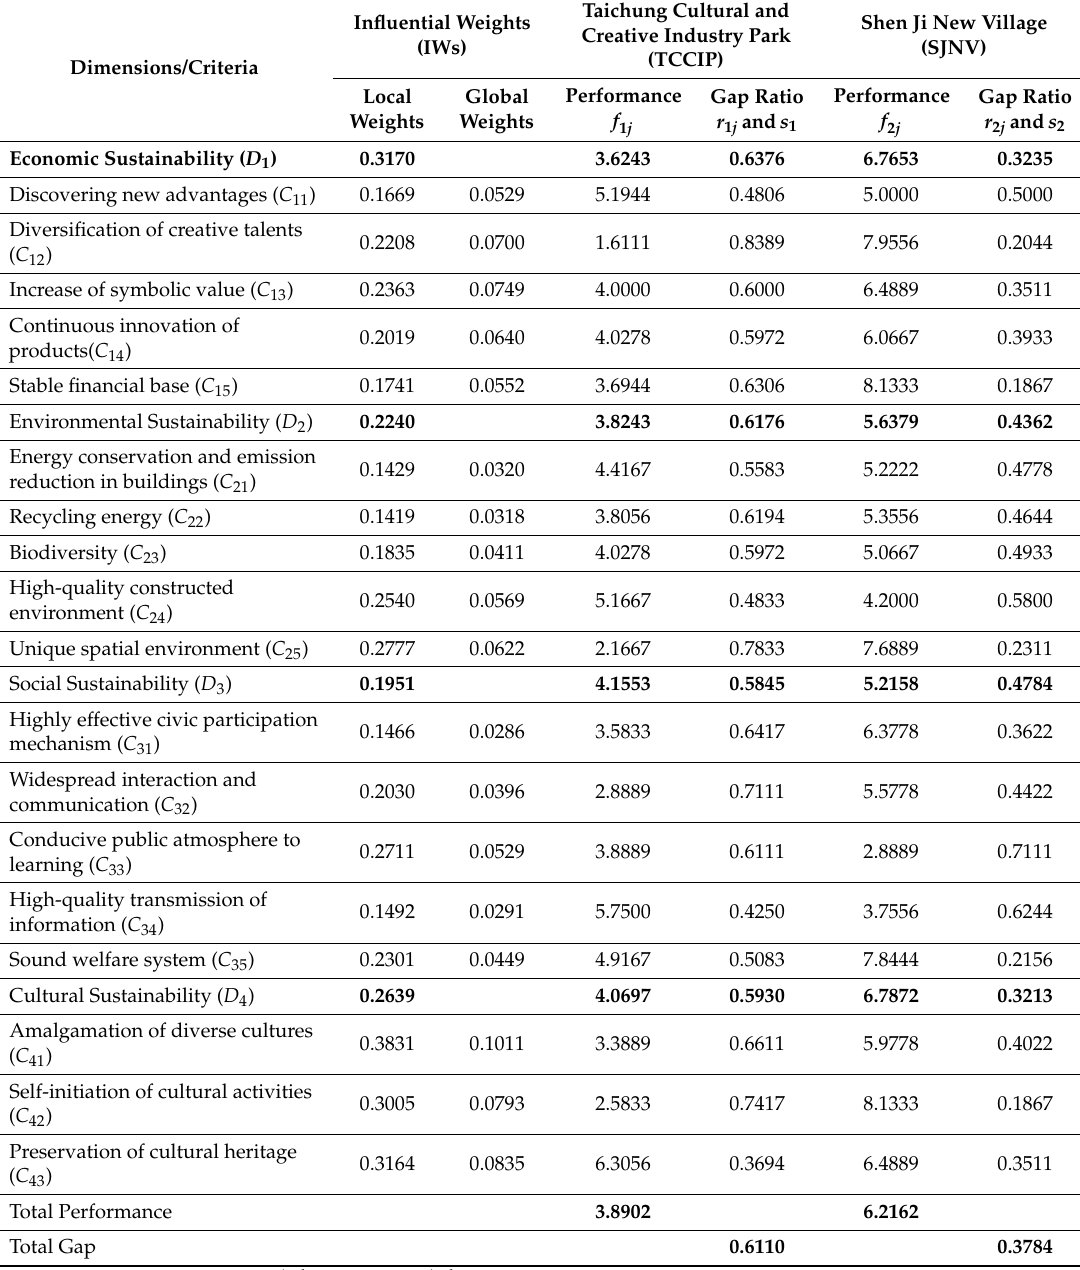
Table 2. The performance evaluation of the case study using